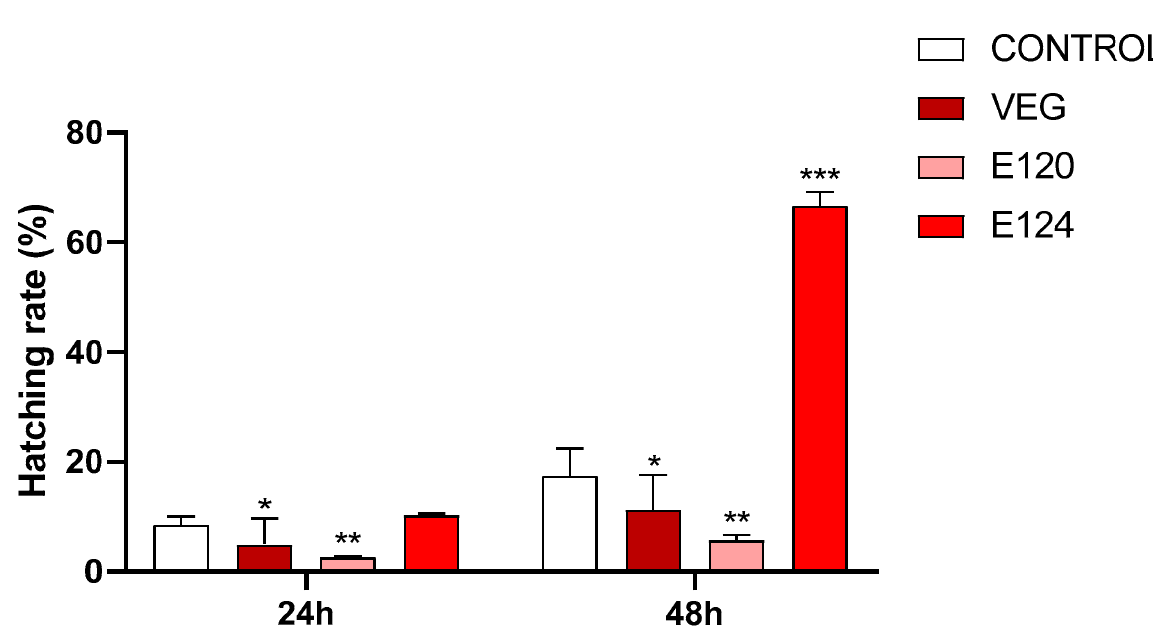
Figure 2. Hatching rate (%) at 24 and 48 h in Artemia salina cysts exposed to vegan red VEG, E120 or E124. Notice the significant decrease induced by VEG and E120 at both 24 and 48 h and the increase induced by E124 at 48 h. (Data are mean ± SEM; * p < 0.05; ** p < 0.01; *** p < 0.001). To better understand the dynamics of naupliar populations, mortality was assessed by daily sampling (Figure 3). Results indicated that mortality remained below 5% until day 4. On day 5, a raise was observed in all samples (range 8–12%), with a significant peak in E124 (16.1% vs. 8.6% of control). On day 6, values increased further, with E124 remaining the most toxic dyes (18.6% vs. 9.7% of control). On day 7, an increase in mortality was